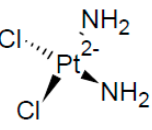
Figure 2. Cisplatin structure.